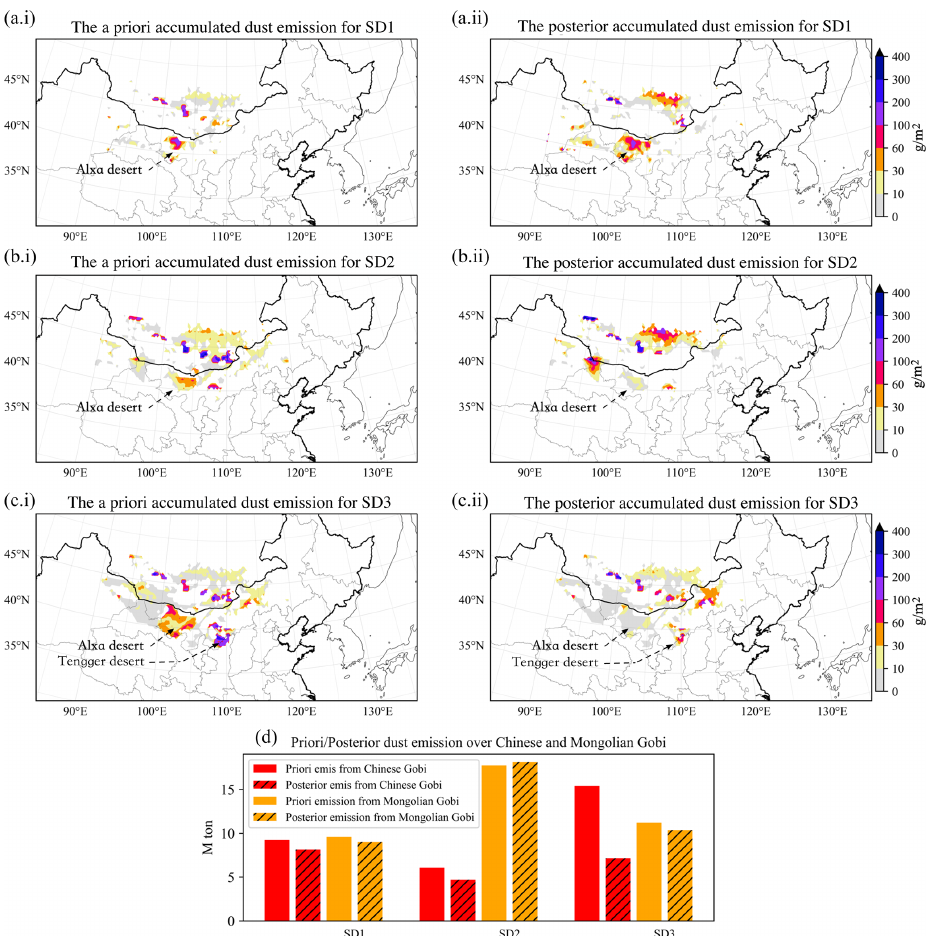
Figure 6. Distribution of the a priori (i) and posterior (ii) accumulated dust emission for the SD1 (a) , SD2 (b) , and SD3 (c) ; the total priori and posterior emission either from China or from Mongolia during SD1, SD2, and SD3 (d)